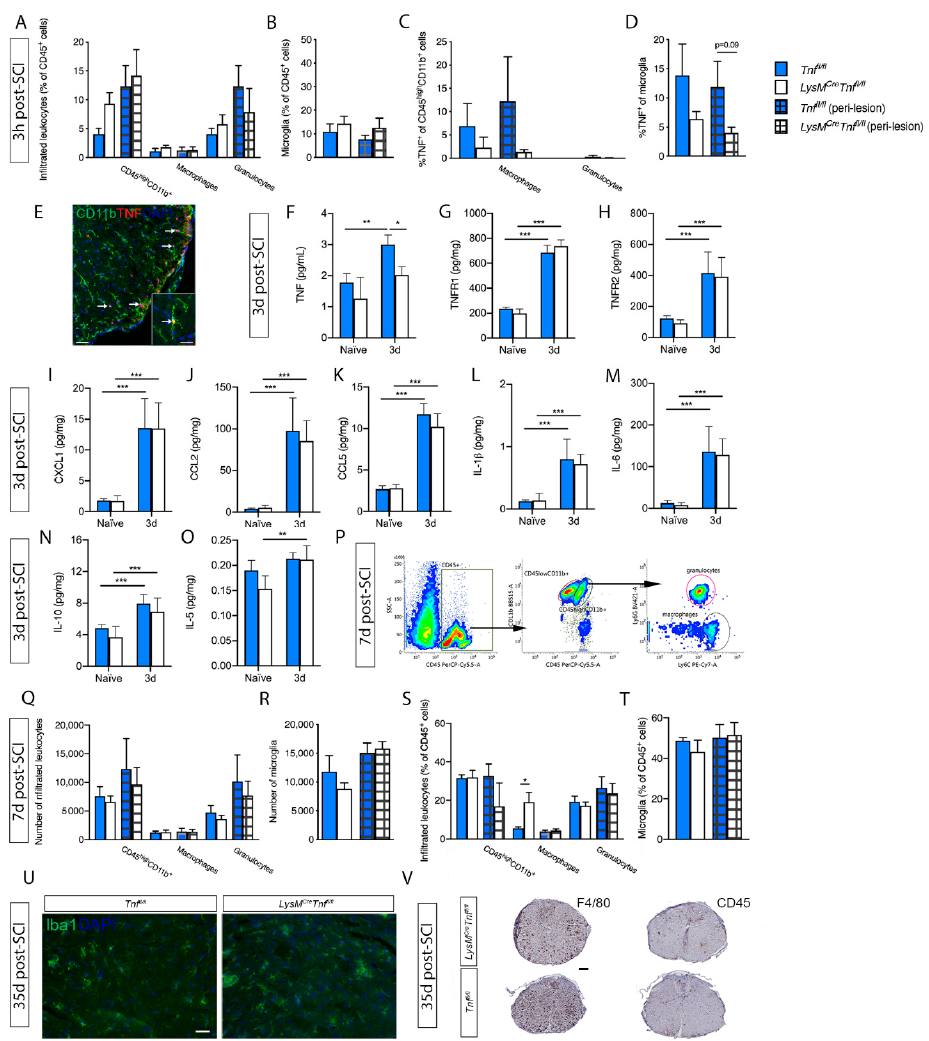
Figure 2. Analysis of spinal cord microglial/leukocyte populations after SCI in Tnf fl/fl and LysM Cre Tnf fl/fl mice. ( A , B ) Leukocyte ( A ) and microglial ( B ) cell populations were comparable between Tnf fl/fl and LysM Cre Tnf fl/fl mice 3h after SCI, n = 5–6/group. ( C , D ) The percentage of TNF + macrophages and granulocytes ( C ) and TNF + microglia ( D ) did not differ significantly between Tnf fl/fl and LysM Cre Tnf fl/fl mice 3h after SCI. ( E ) Double immunofluorescent labeling of TNF with CD11b, demonstrating TNF expression in microglia (arrows). Scale bar: 100 μ m. Insert: high magnification of a ramified TNF + microglia (arrow). Scale bar: 20 μ m. ( F – O ) TNF (two-way ANOVA; SCI p < 0.0001, F 1,16 = 27.15; genotype p < 0.01, F 1,16 = 15.5; interaction: ns) ( F ), TNFR1 (two-way ANOVA: